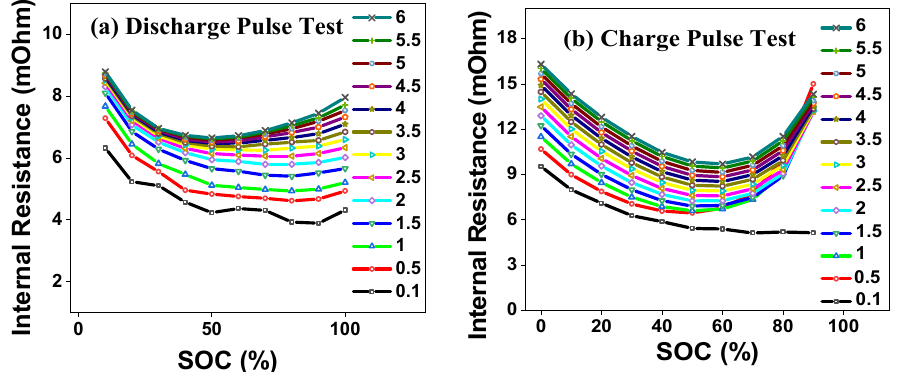
Figure 5. Internal resistance vs. SOC (%) profile ( a ) for discharge pulse ( b ) for charge pulse.